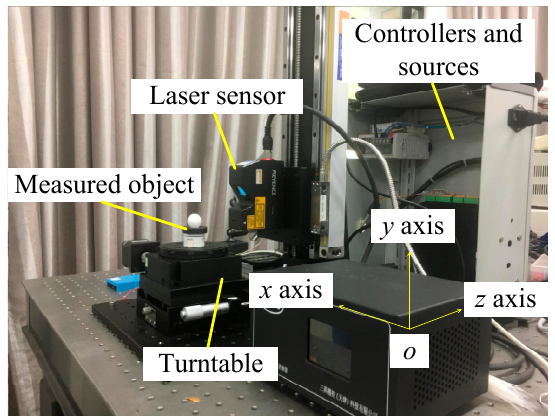
Figure 10. Components of the experiment platform and the world coordinate system used in this paper.